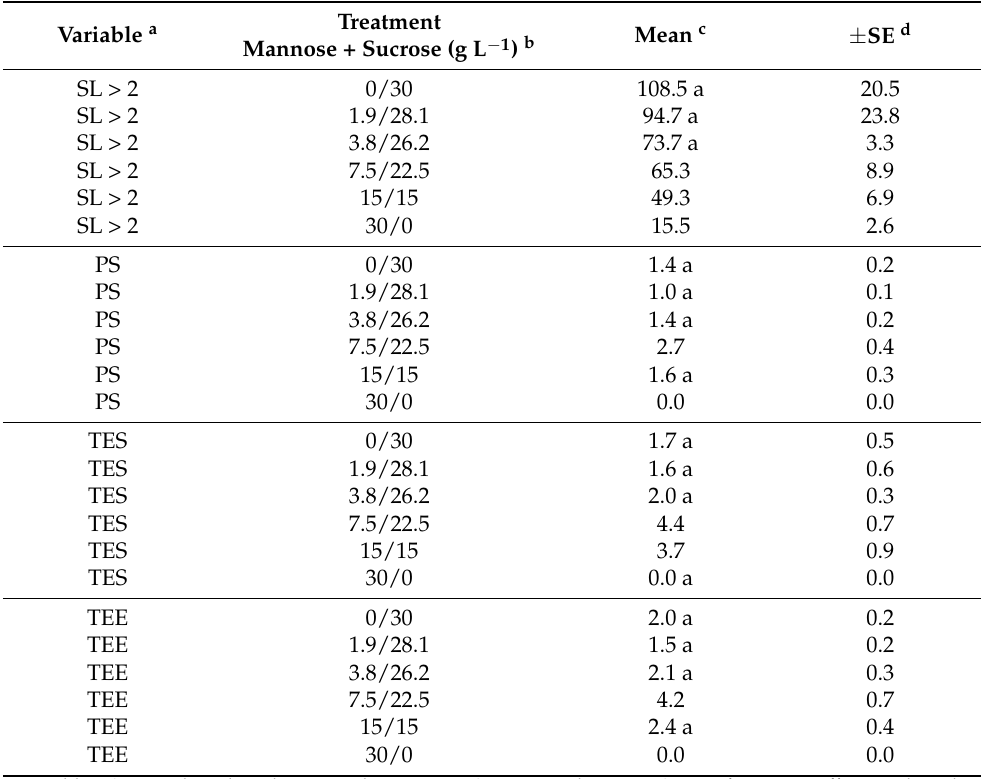
Table 4. CsPMI2 means, multiple comparisons, and standard errors for the different variables. Variable